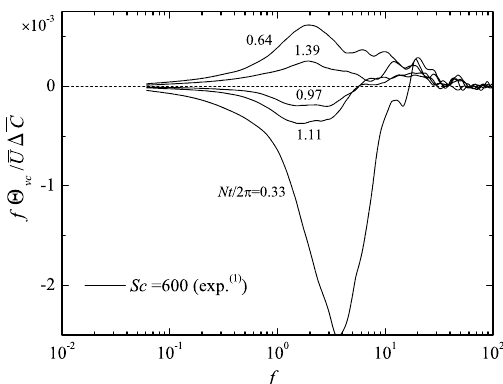
Fig. 6 Time variation of the cospectra of the vertical turbulent scalar (mass) flux in the salt-stratified flow obtained in the previous laboratory measurements (1) . f denotes the frequency, and the cospectra are pre-multiplied by f . The cospectra are normalized by the mean velocity U and the di ff erence between the initial concentrations of the upper and lower streams in the mixing-layers type grid turbulence, Δ C